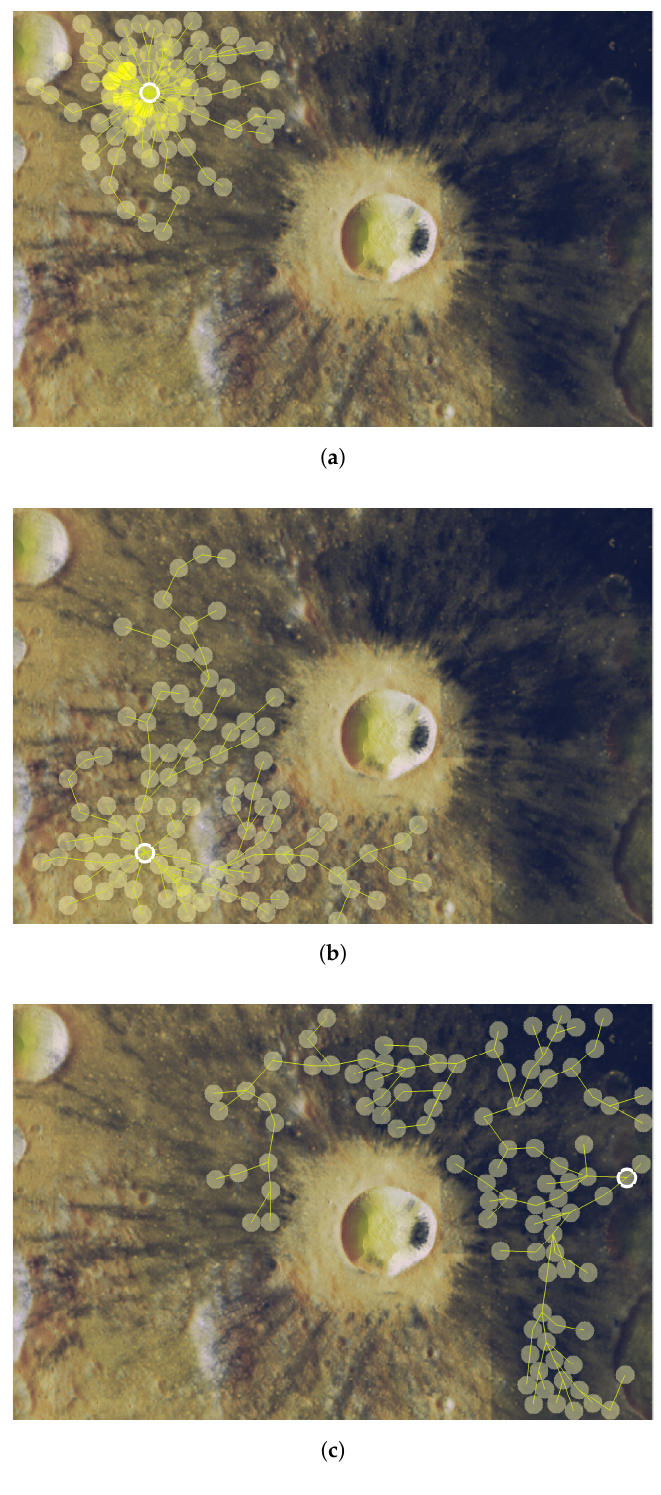
Figure 12. Sensing coverage of TiO 2 content in the Dionysius region of interest. ( a ) θ = 0.0025, f 1 / Γ max = 0.1608 and f 2 = 4067; ( b ) θ = 0.05, f 1 / Γ max = 0.5282 and f 2 = 14179; ( c ) θ = 0.36, f 1 / Γ max = 0.8176 and f 2 =